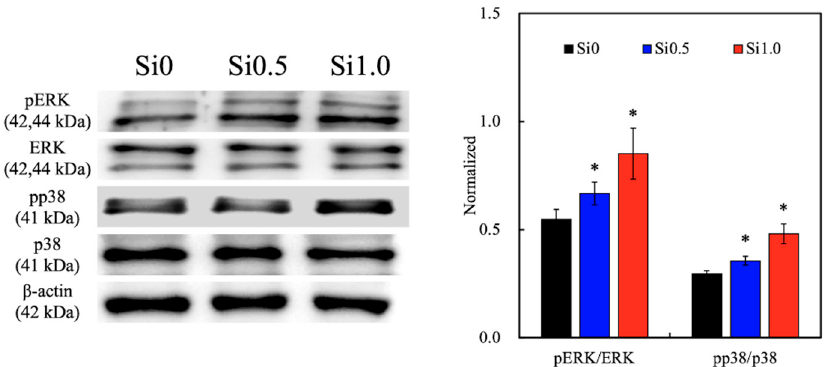
Figure 7. Western blotting and quantification results of phospho-extracellular signal-regulated kinase (pERK), extracellular signal-regulated protein kinases (ERK), pp38 and p38 expression of hDF cultured on Si-GelMa hydrogels for 1 day. “*” indicates a significant difference ( p < 0.05) compared with Si0.